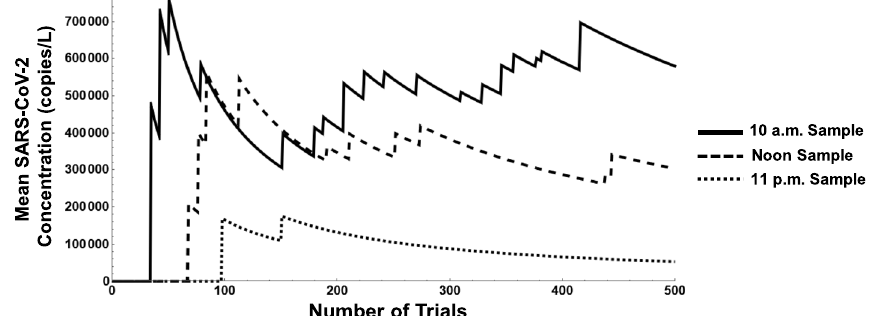
Fig. 7 Simulation output, rolling mean SARS-CoV-2 concentration (L/s) when population infected is 15%, viral load is 10 10 , and grab sample times are